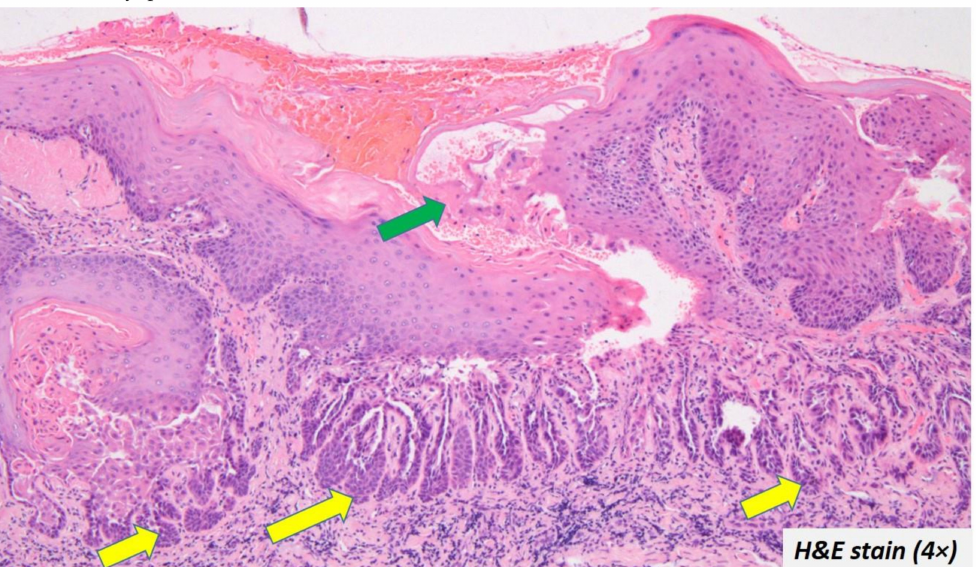
Figure 4. Ortho/parakeratin debris filled the depressed epithelium (green arrow) and some cases also exhibited pseudo-epithelial proliferation (yellow arrow).